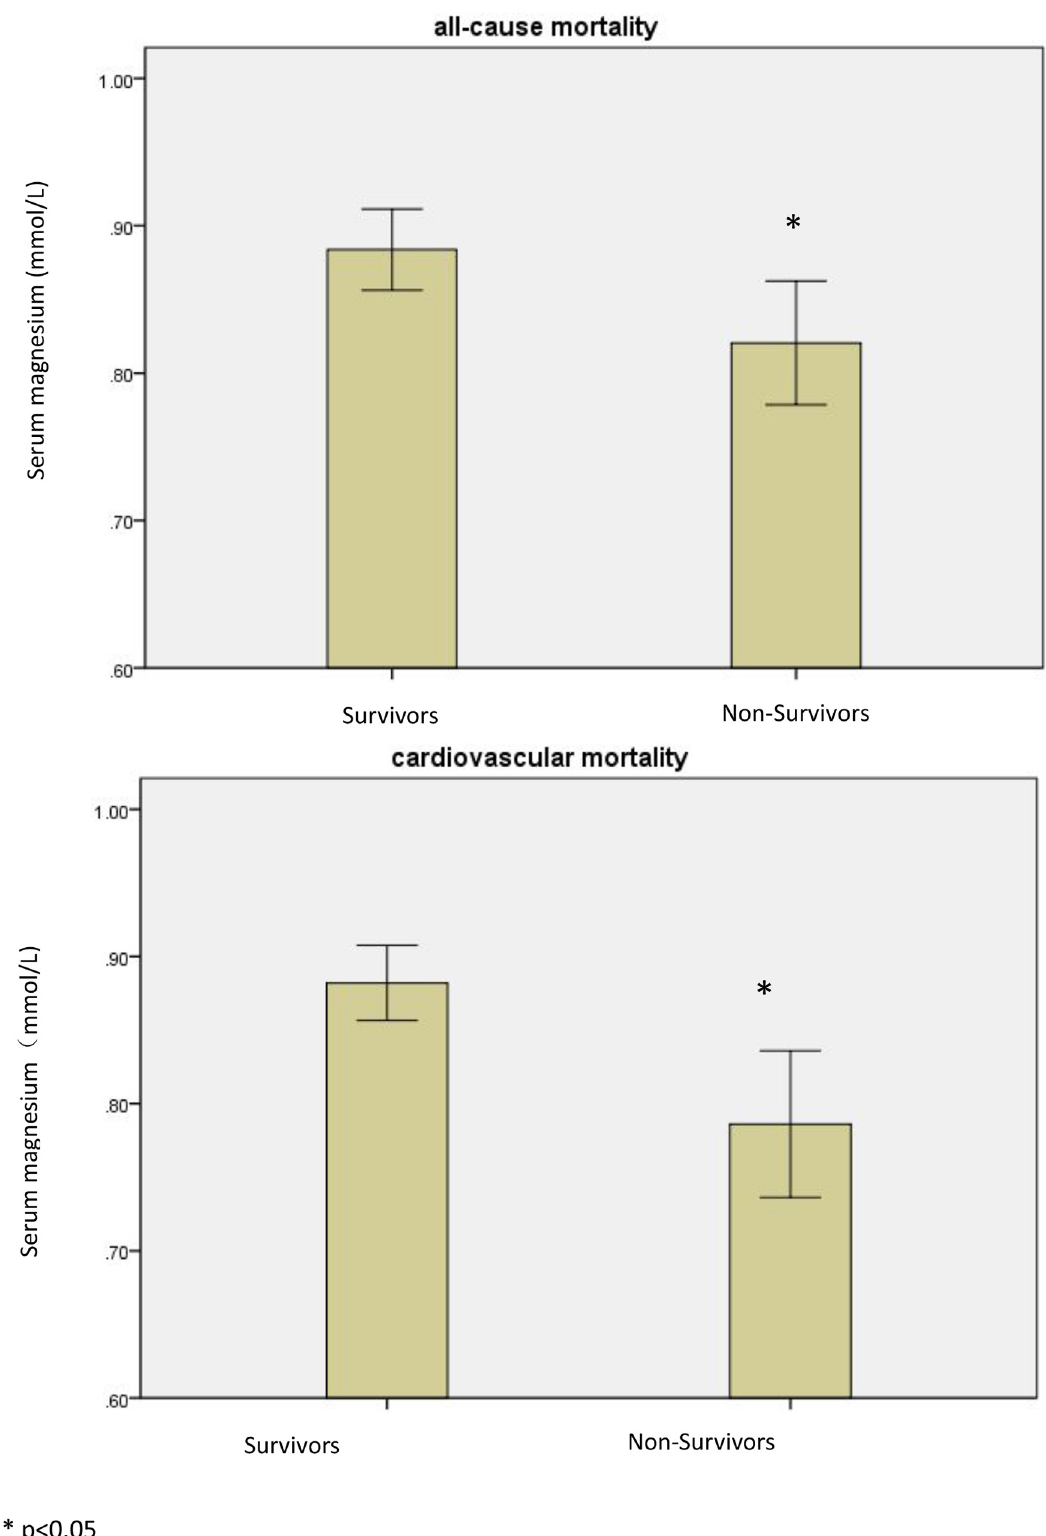
Fig 2. Patients who died from either all-cause or cardiovascular-only cause had significantly lower magnesium levels.